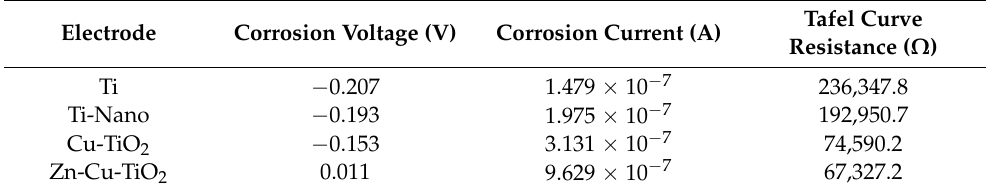
Table 1. Results of the metal corrosion rate